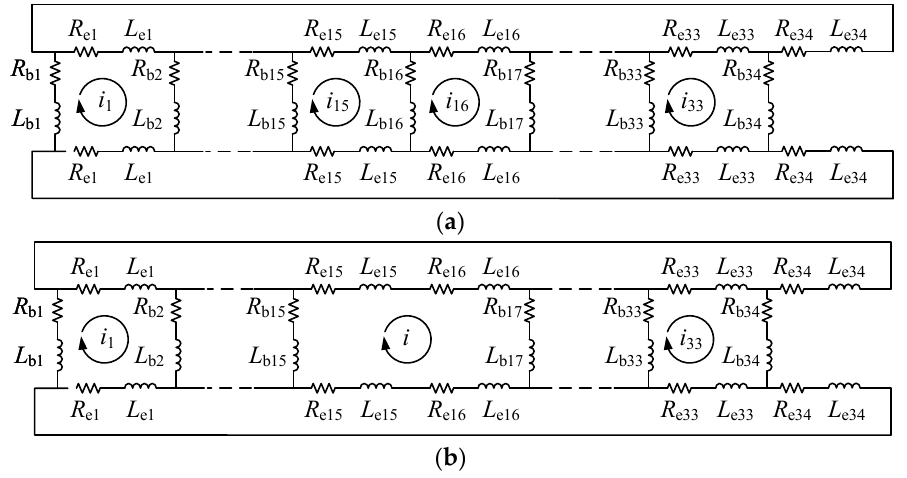
Figure 2. Model of circuit with BRB fault: ( a ) normal rotor; ( b ) broken #16 bar. In Figure 2, R e and L e are the respective end ring resistance and the inductance, R b and L b are the respective conductor resistance and inductance, and i is the rotor loop modes of the normal rotor bar, one broken bar, two broken bars and three broken bars are set, respectively. Finite element joint simulation covering the starting process is then car- ried out. The resulting motor starting current waveform (taking phase A as an example) and the rotation speed waveform are shown in Figures 3 and 4, respectively.